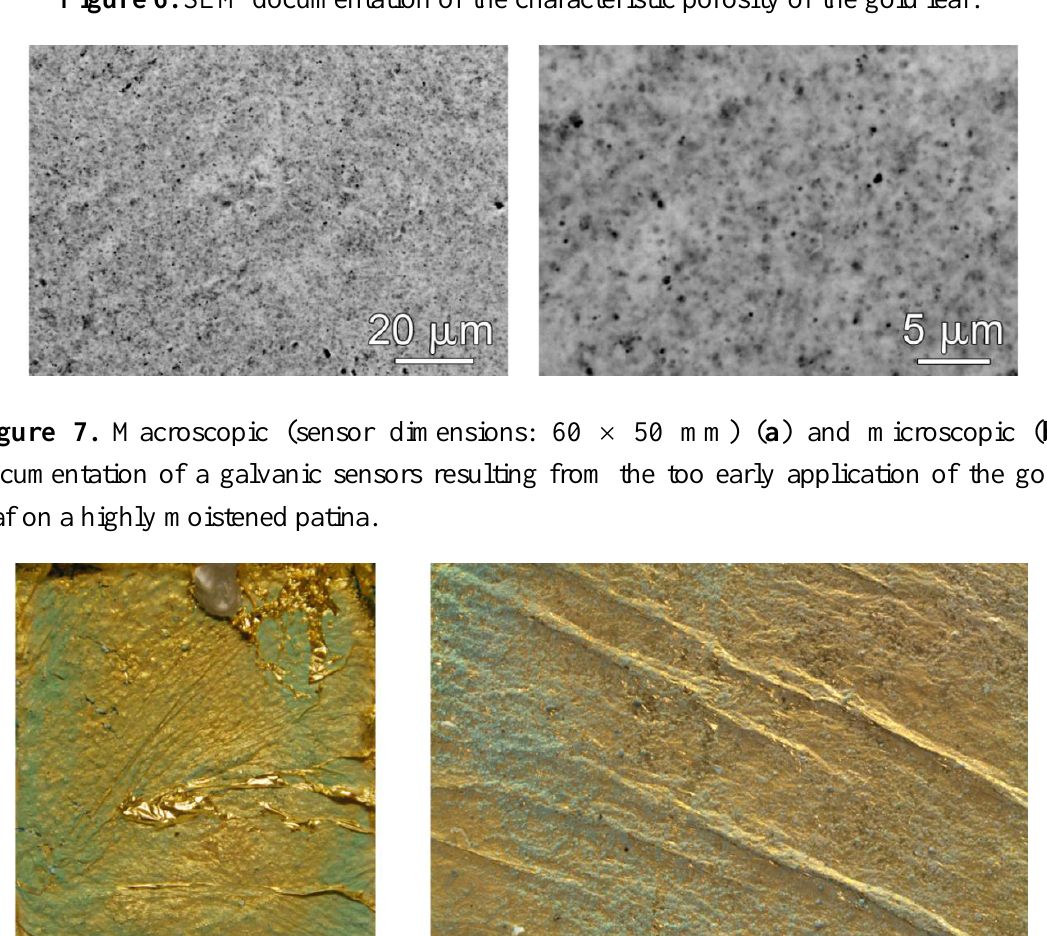
Figure 6. SEM documentation of the characteristic porosity of the gold leaf.